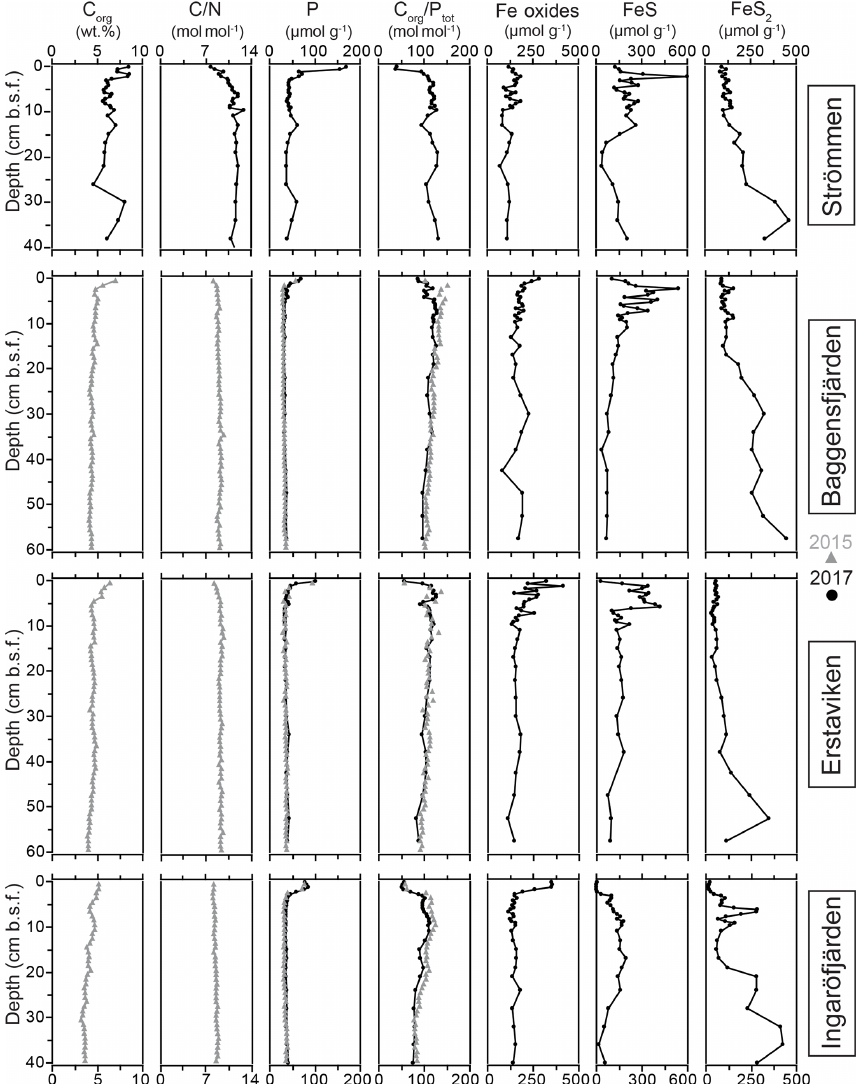
Figure 5. Solid-phase depth profiles of C org , C / N, P, C org / P tot , Fe oxides, FeS (AVS-derived) and FeS 2 (CRS-derived) for the study sites in the Stockholm archipelago: Strömmen, Baggensfjärden, Erstaviken and Ingaröfjärden. Grey triangles are data from van Helmond et al.